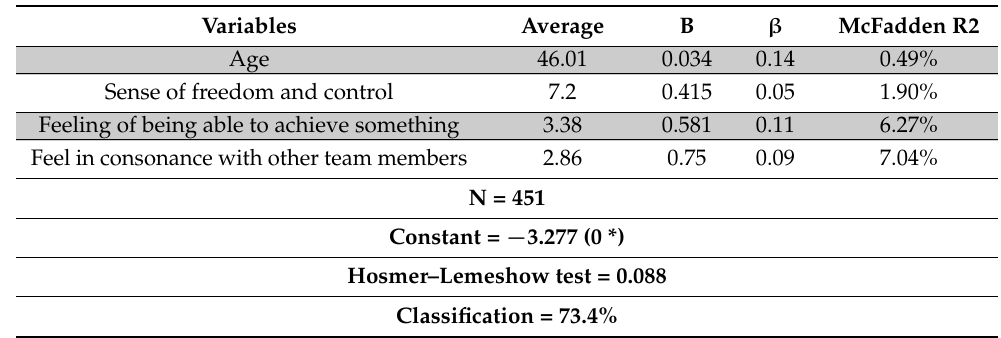
Table 7. Logistic Regression Model